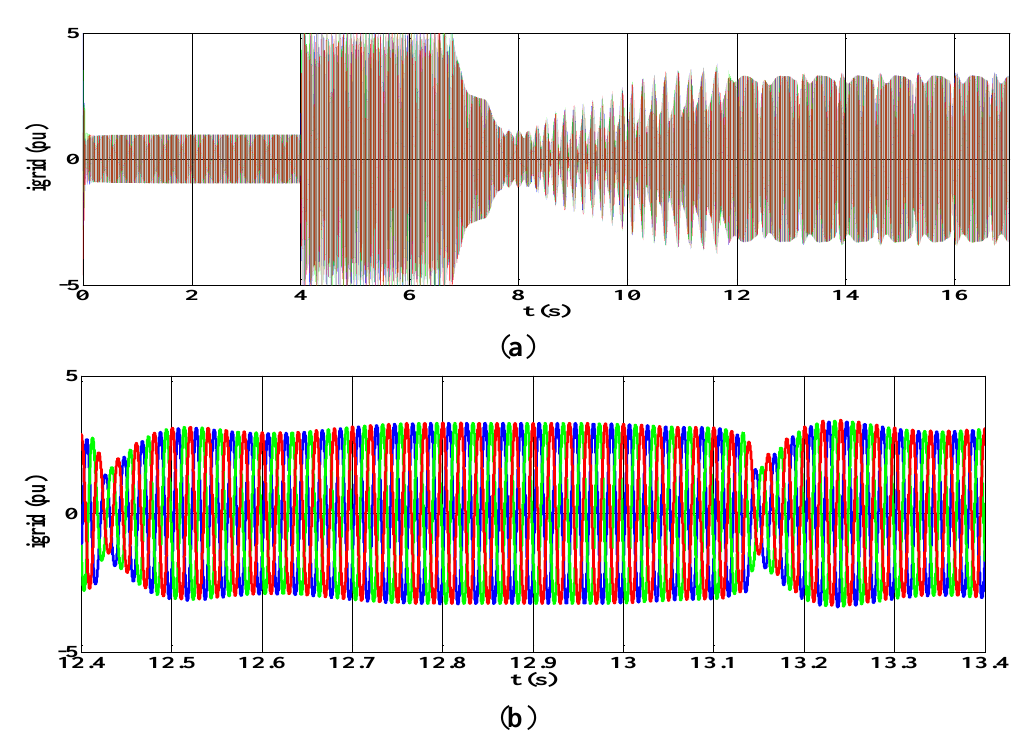
Figure 14. ( a ) Grid phase currents I gridabc (short-circuit happens at t = 4 s), ( b ) zoom of